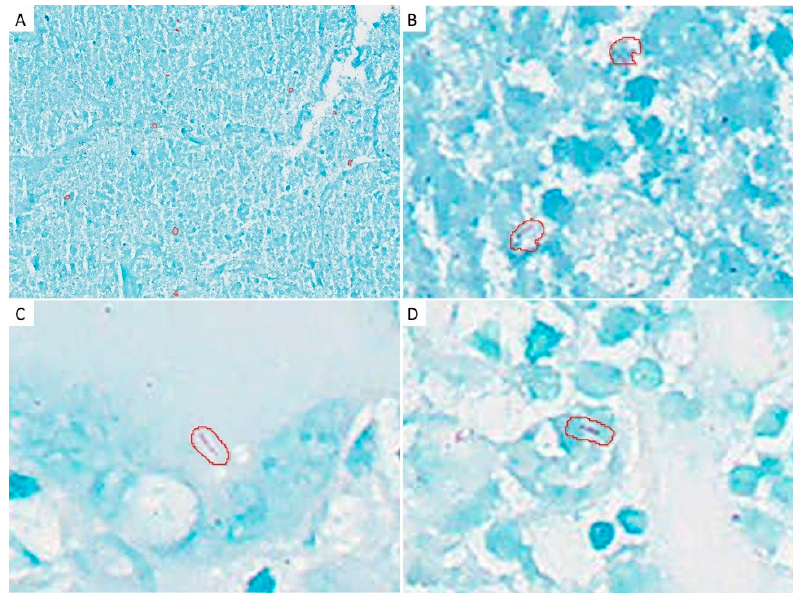
Figure 2. Examples of acid-fast bacilli (AFB) recognized by AI in the study cohort: ( A ) AFB observed in a relatively large group (middle magnification); ( B ) High magnification; ( C ) AFB was observed sporadically at high magnification; ( D ) An example in which AI determined AFB, but the pathologist determined it as a false positive.